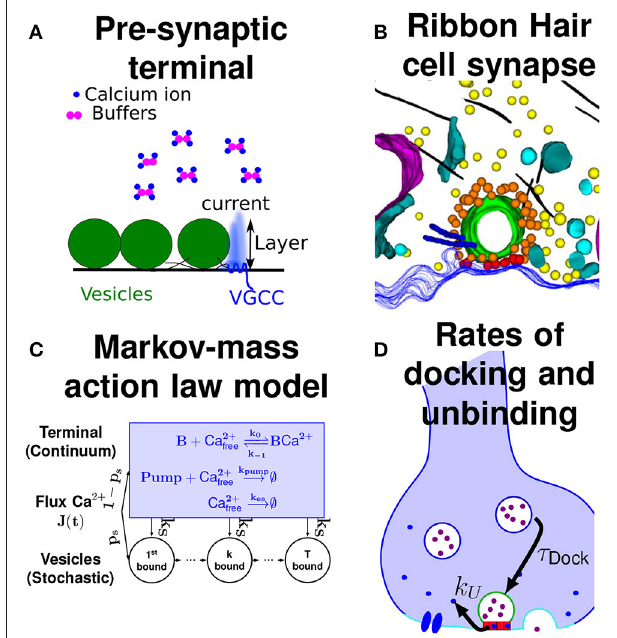
FIGURE 3 | Various model of the AZ. (A) The entering flux of calcium ions (blue) through a VGCC, could be affect by the vesicle geometry. The flux penetrates inside a layer of tens of nanometers. Buffers (purple) can bind calcium ions. (B) Hair cell synapse containing a circular ribbon (green) that could generate a micro-domain to retain calcium between the boundary layer near the membrane and the pre-synaptic bulk (reproduced from Graydon et al., 2011). (C) Summary of the Markov-Mass action model, showing how the initial flux is split between the calcium vesicular sensor and the bulk (Guerrier and Holcman, 2016). (D) Illustration of the rates: for replacing vesicles 1 τ Dock and for calcium unbinding k U from the calcium sensor (red